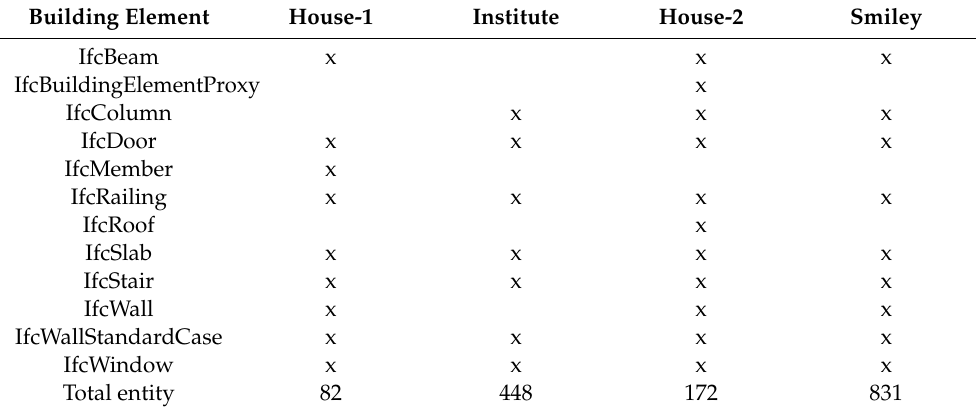
Table 3. Building elements in models and total quantity of entities for each element. ”x” indicates the inclusion of a building element.